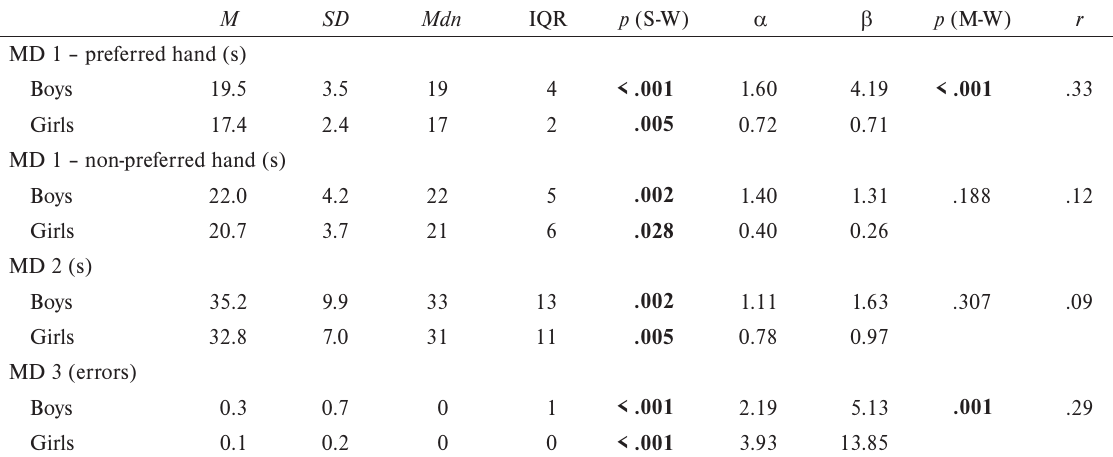
Descriptive characteristics of performance in the manual dexterity